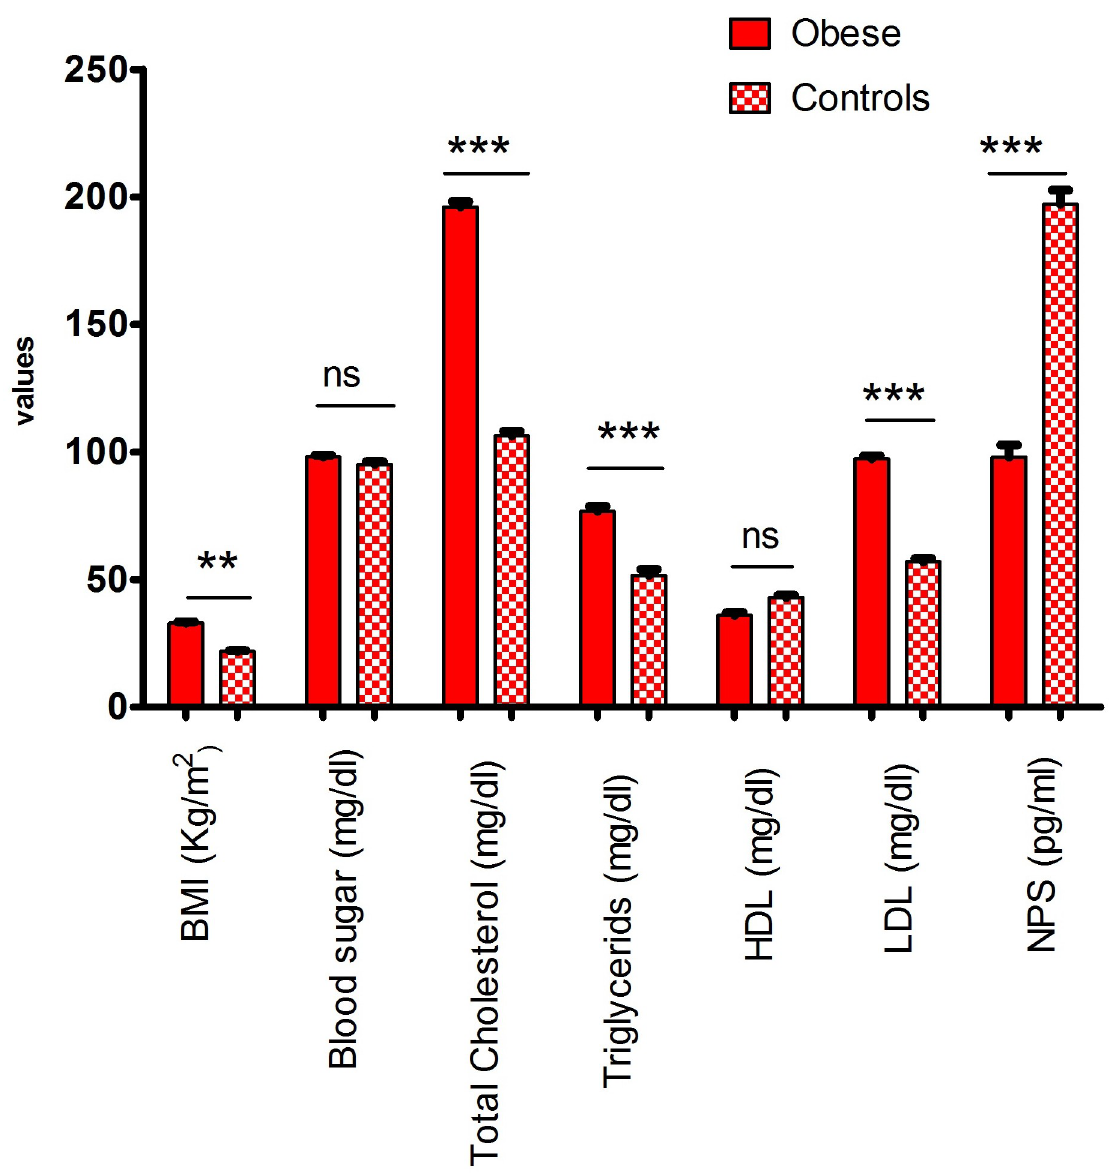
Fig 1. Lipid profile and anthropometric parameters vary significantly between obese and control groups.